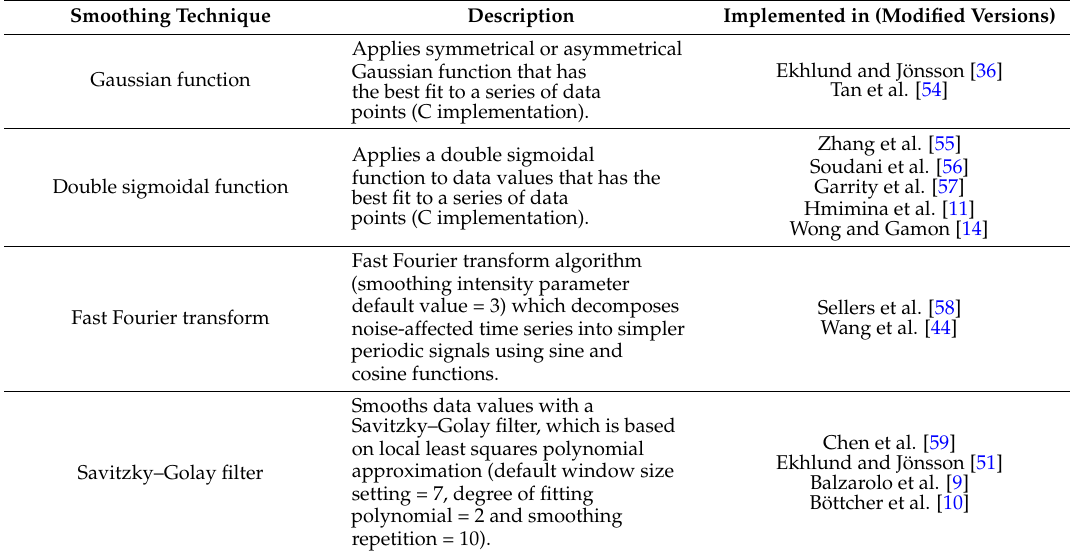
Table 1. Selected smoothing methods, which are available in the Phenex package by Doktor and Lange